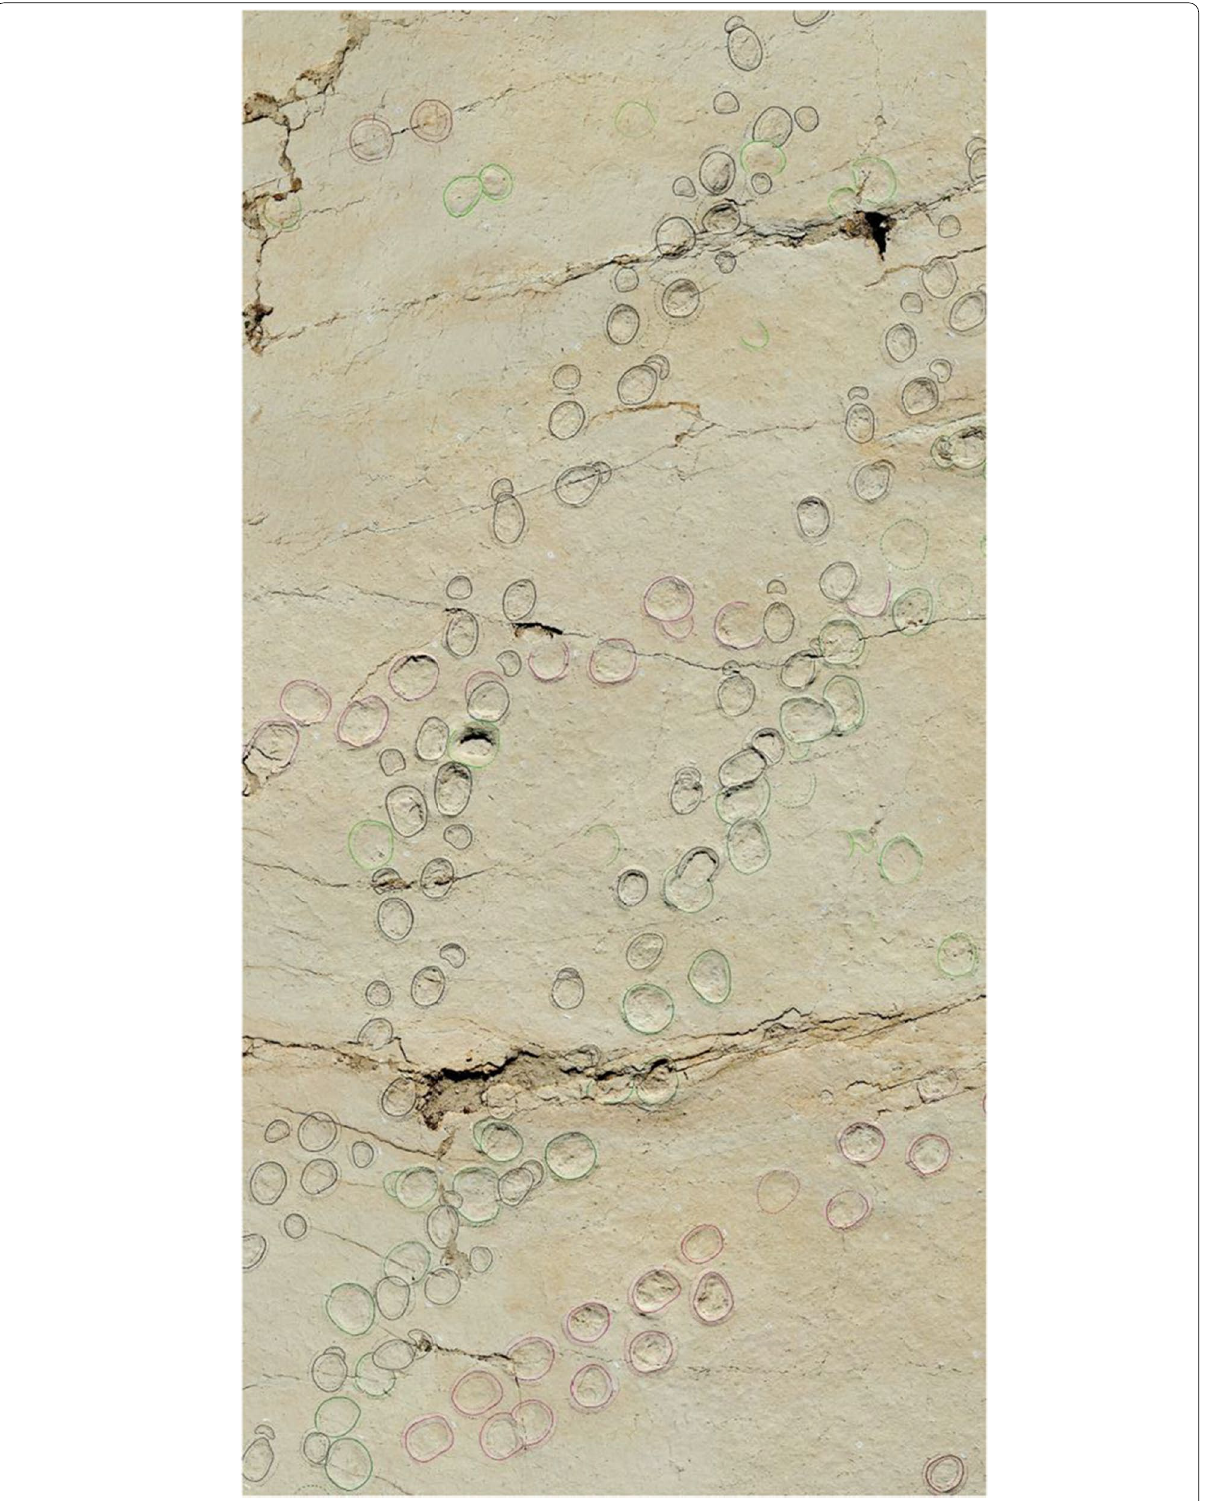
Fig. 3 An orthophotograph of a small portion of the BEB-515 level of the Courtedoux-Béchat Bovais tracksite. Note that multiple trackways were identified with differing trackway patterns (some have distinct manus and pes tracks, and others have only pes tracks). This image covers an area of 20 m by 10